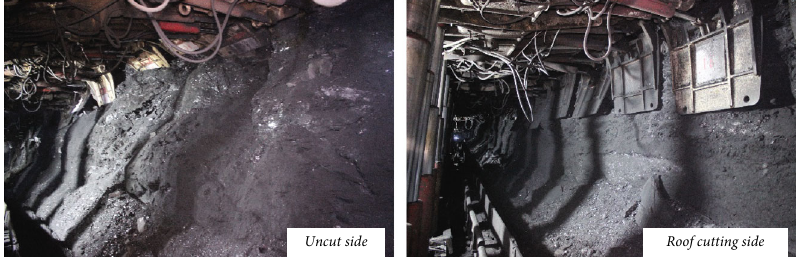
Figure 8: Condition of coal wall collapsing during the initial weighting of the main